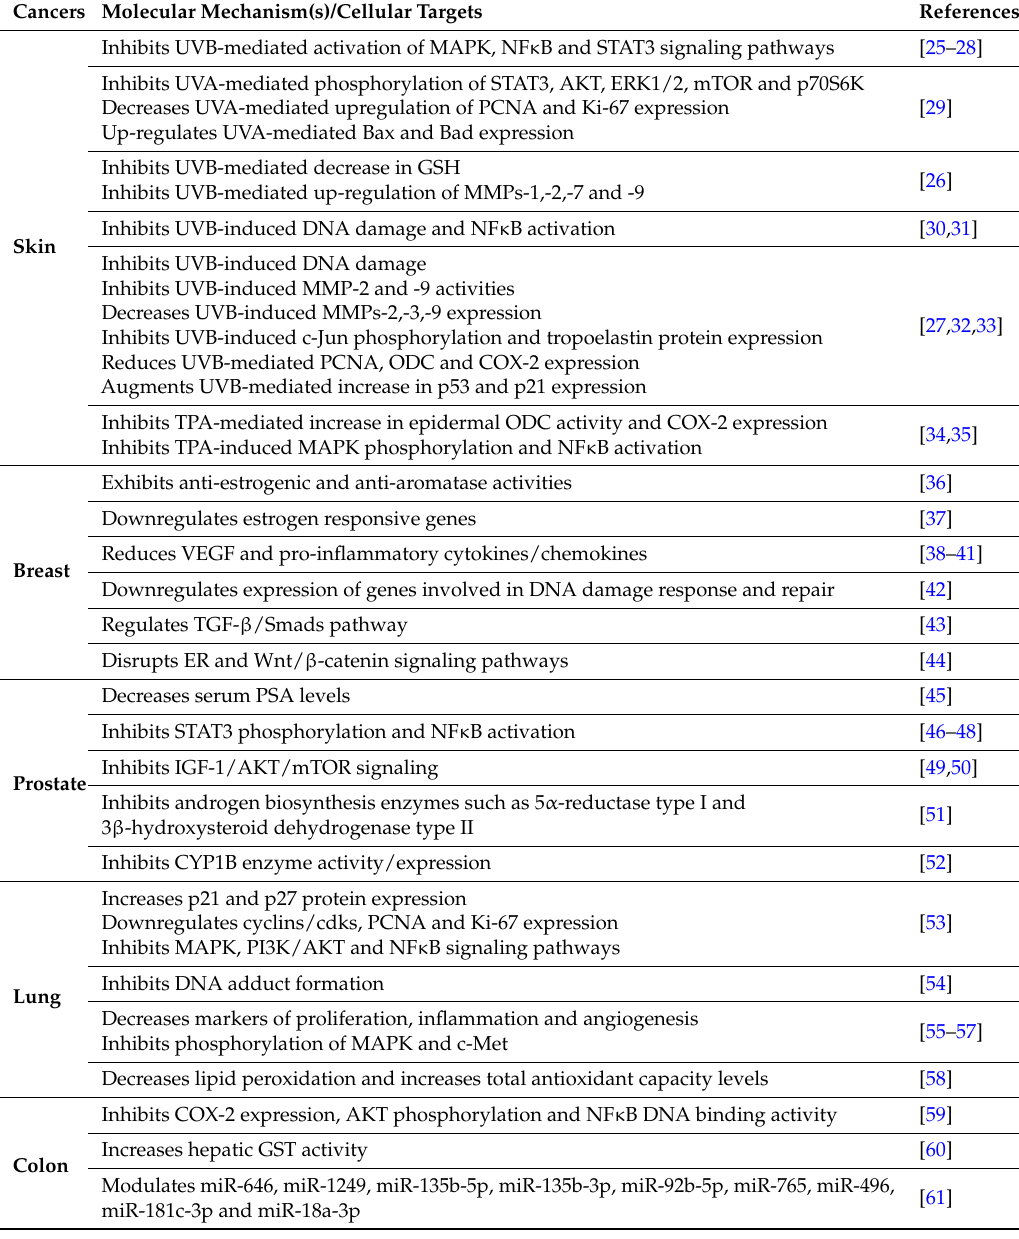
Table 1. Molecular targets of pomegranate in